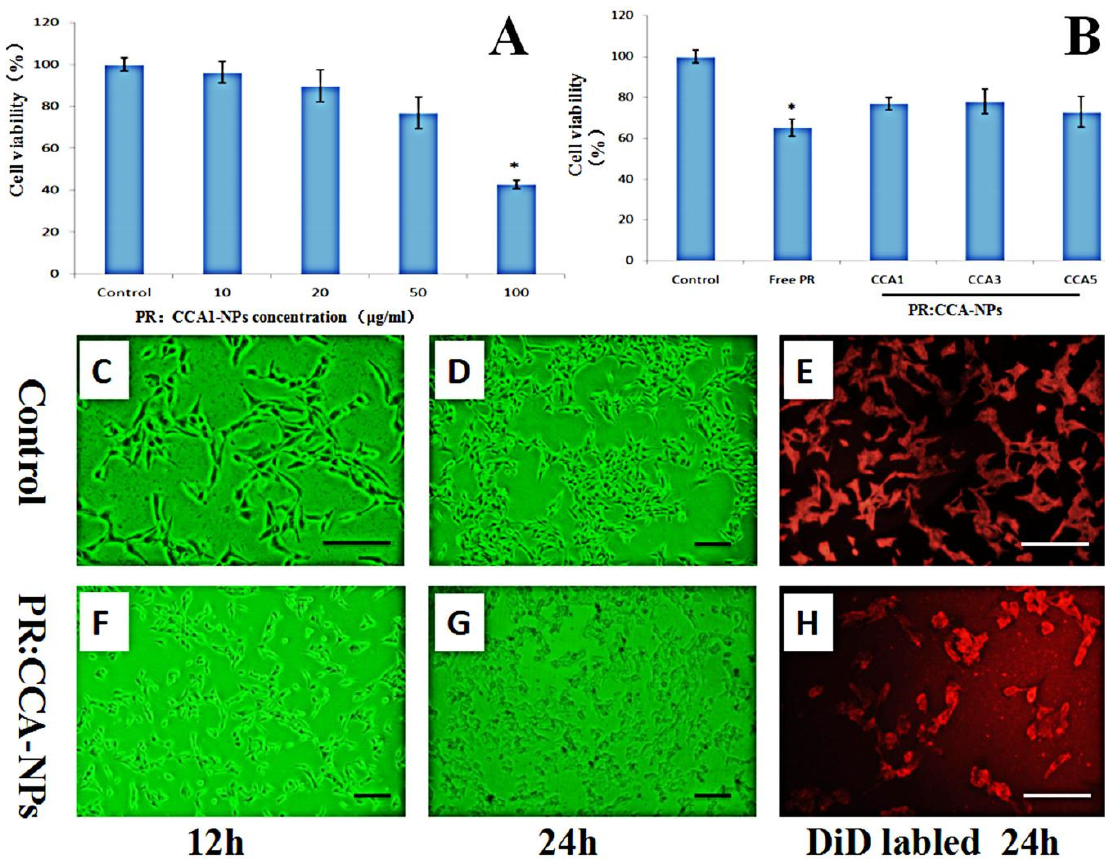
Figure 5. Effects of different concentrations of nanoparticles ( A ) and different PR:CCA-NPs ( B ) on the proliferation ability of B16 cells (24 h); Observing the B16 cells of mice at different time under inverted microscope ( C , D , F , G ) ; Cells were stained with DiD to visualize membrane morphology ( E , H ). Note: the scale bar represents 25 μ m; * P < 0.05 vs control.